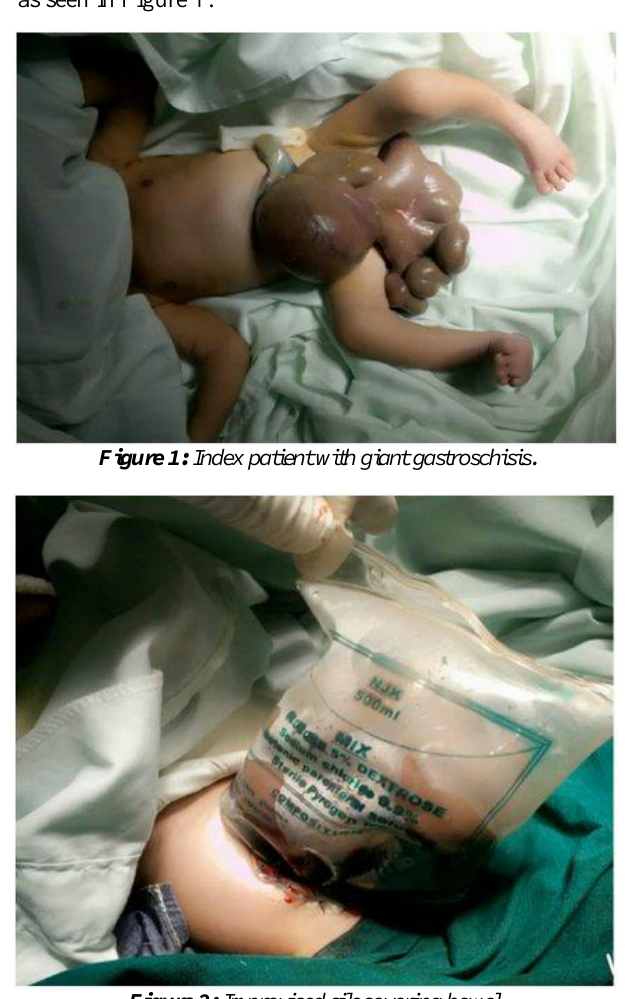
Figure 2: Improvised silocovering bowel.